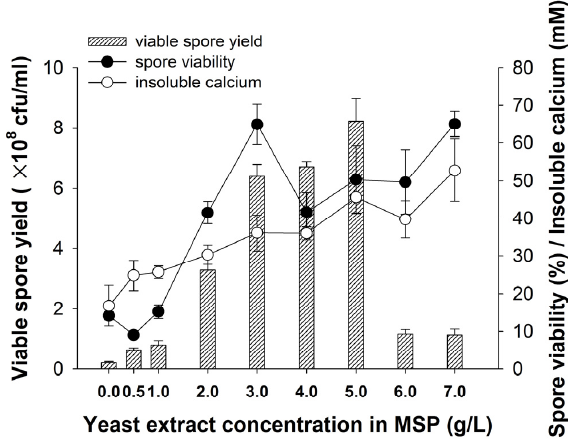
Figure 1. Effect of yeast extract on viable spore yield, spore viability and calcium precipitation.